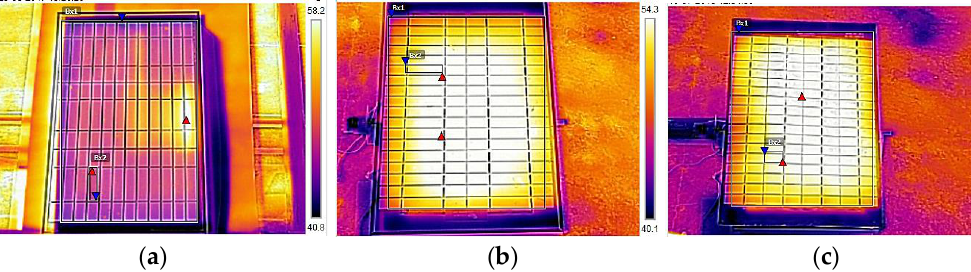
( b ) induvial cell Figure 5. Percentage of thermal pixels variation of PV panel under different ∆T °C conditions. The EVA discolouring defect increases the thermal pixel of the panel and cell in the band of T 15 C compared than healthy condition. The delamination defect increases the thermal pixel of the panel and cell in the band of T 20 C . The percentage variation of the thermal pixel gives the accurate identification and classification of the EVA discolouring and delaminated defects from the healthy panel. Figure 6; Figure 7 show the modified thermal image for Tmin + 15°C and Tmin + 20°C. From the figure, the defects of the panel and cell-based on the temperature pixel intensity are observed. The performance of the proposed TPC algorithm can be verified by quantifying the results